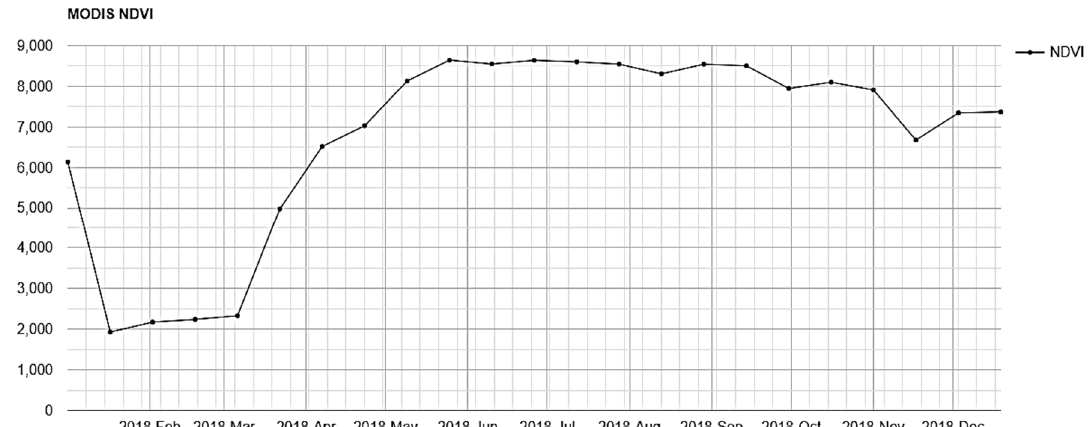
Figure 7. MODIS NDVI time series of the year 2018 extracted using GEE platform. NDVI values in y -axis are expressed at a scale factor of 10,000.